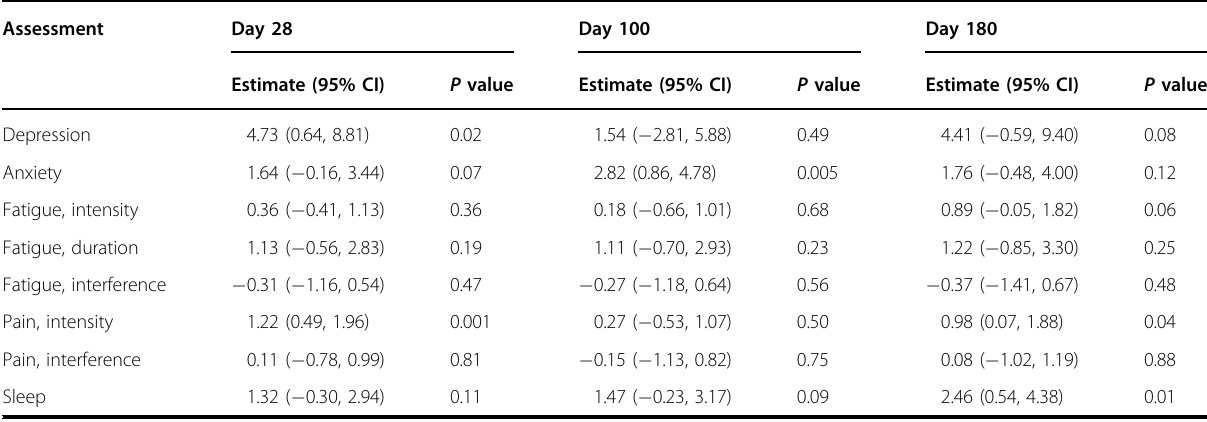
Table 3 Tocilizumab compared to control cohort based on propensity-weighted a models for quality of life patient- reported outcomes after adjusting for baseline values and aGVHD (grades II – IV).